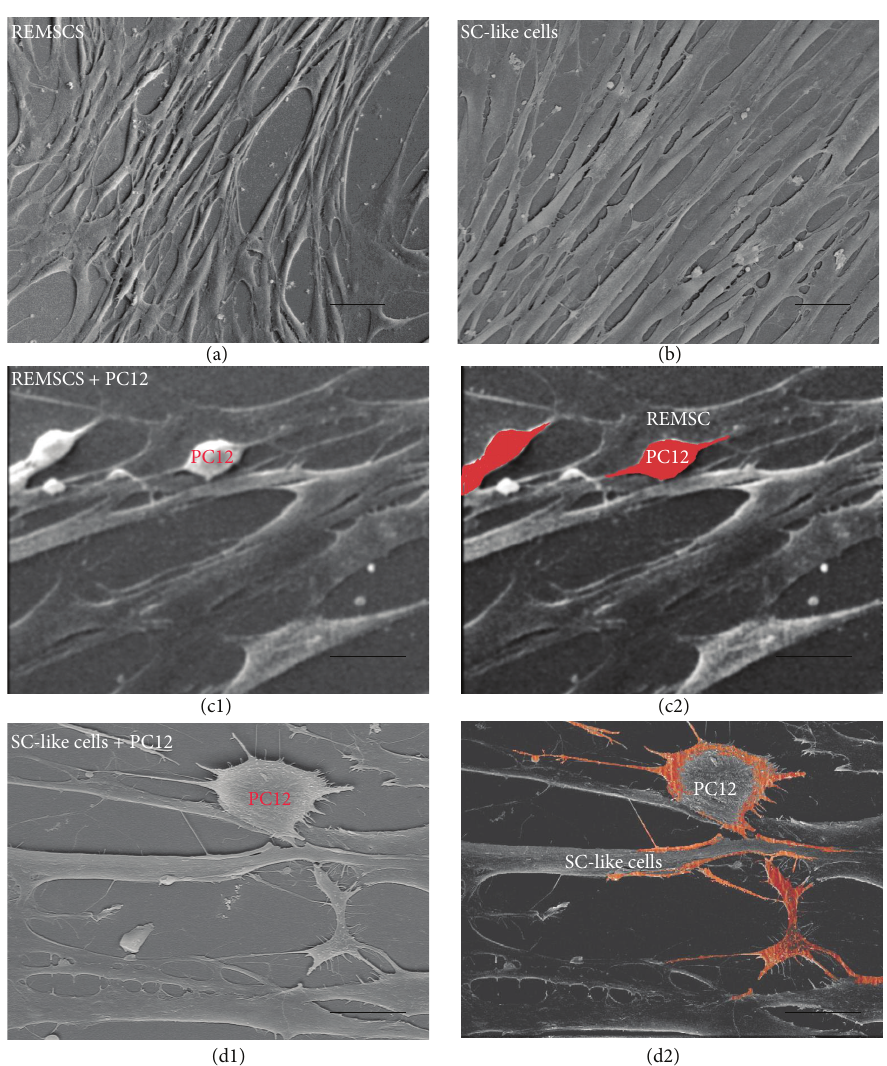
Figure 8: Morphology of REMSCs, SC-like cells, and PC12 cells cocultured with REMSCs or SC-like cells was observed under SEM. REMSCs cultured in DF12 medium (a) and SC-like cells cultured in SCDM (b), PC12 cells (marked with red) cocultured with REMSCs in DF12 medium (c1, c2), and PC12 cells (marked with red) cocultured with SC-like cells in SCDM (d1, d2). The imaging showed that the neurites of PC12 cells in (d1, d2) were longer than that in (c1, c2), and the neurites grew along with SC-like cells. Bar: 20 𝜇 m for all